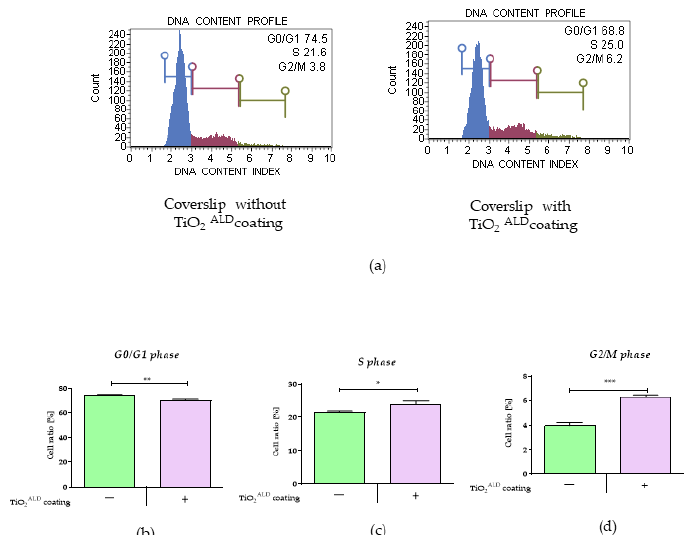
Figure 6. The results of the analysis of the control culture (TiO 2 ALD coatings-) and a culture propagated on TiO 2 coatings (TiO 2 ALD coatings +; experimental culture), showing the distribution of cells in the cell cycle: ( a ) Representative histograms show the distribution of MC3T3 cells in the cell cycle phase under both culture conditions. The cells were separated into three populations: G0/G1 phase (the left side), S phase (the middle), and G2/M phase (the right side). The results of statistical analysis revealed differences in cell distribution during the ( b ) G0/G1 phase, ( c ) S phase, and ( d ) G2/M phase. (significant differences are marked with asterisks (*** p < 0.001; ** p < 0.01; * p < 0.05).